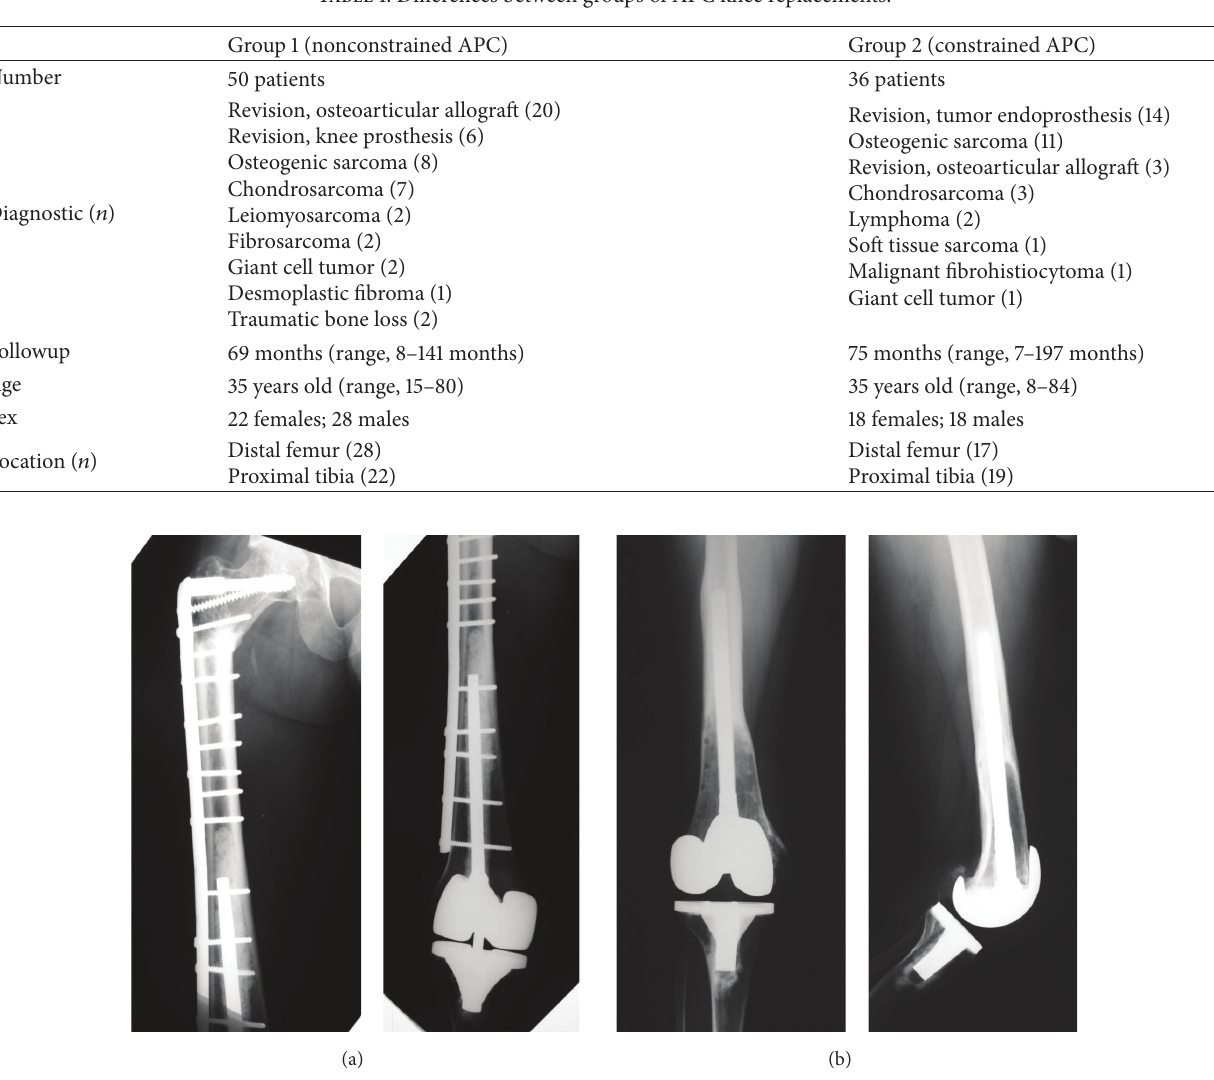
Figure 1: Reconstructions performed for distal femur in Group 1. (a) Distal femoral APC with a short stem. (b) Distal femoral APC with a long